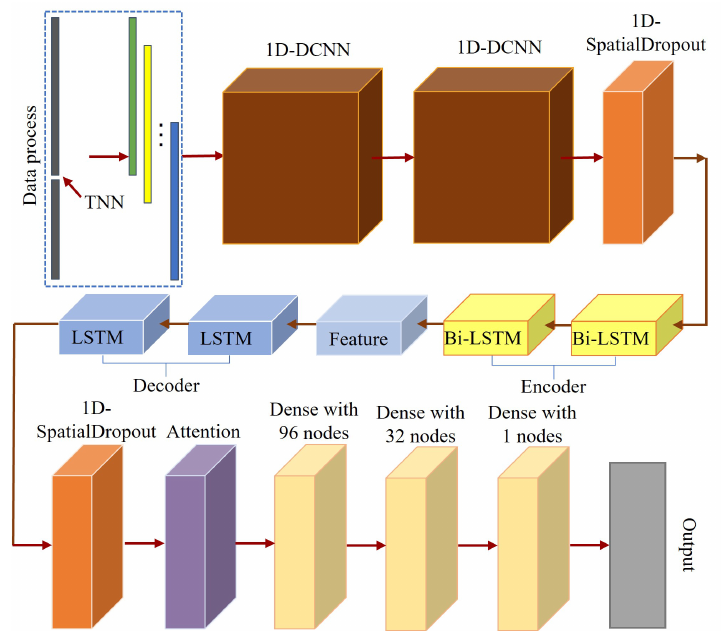
Figure 3. Process of residential short-term load